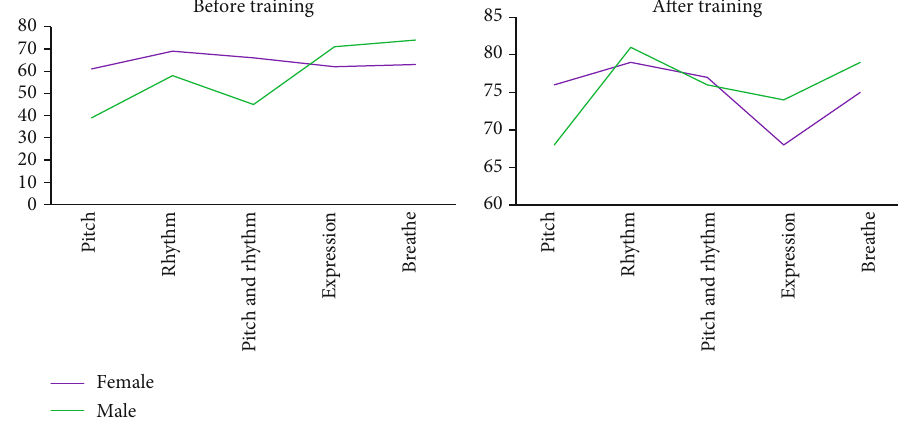
Figure 10: Comparison of di ff erences in performance between men and women in music reading